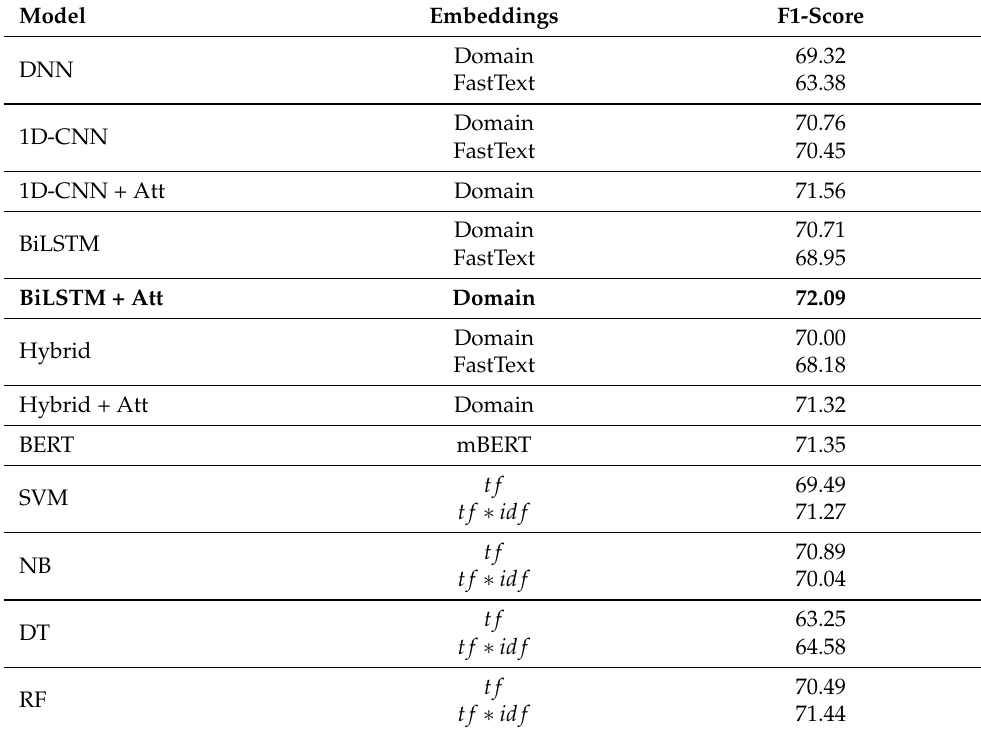
Table 12, BiLSTM with an attention mechanism and word embeddings generated from our collected dataset outperforms the other classifier models, achieving an F1 score of 72.09%. Table 12. Summary of the results for all the classifier models trained and validated on our dataset.